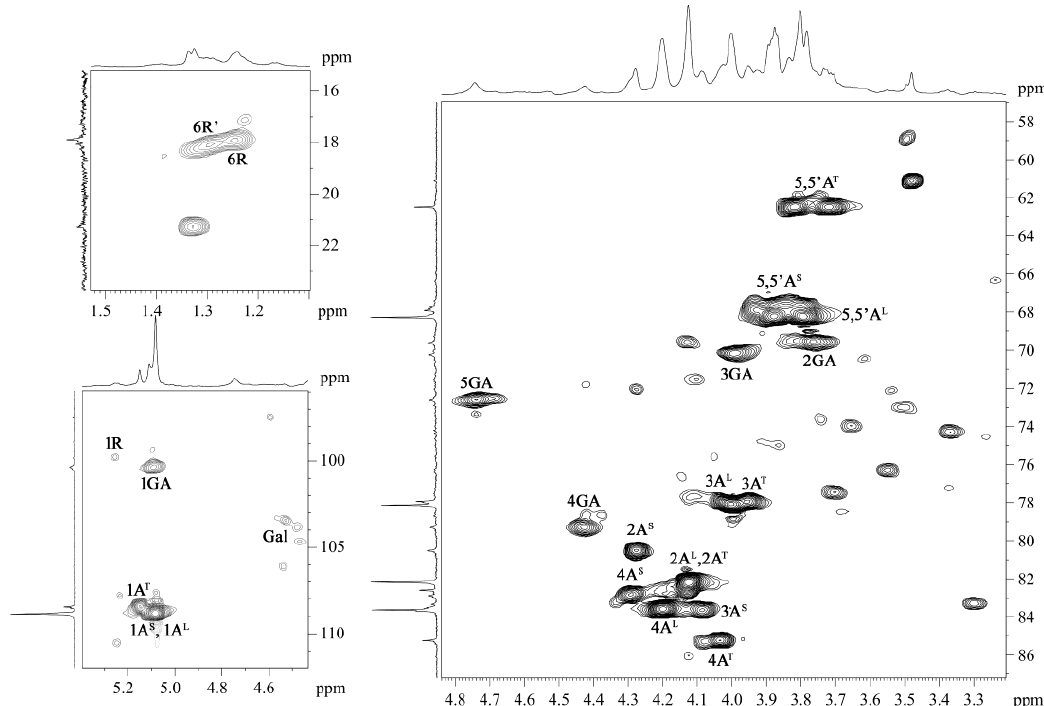
Figure 4. Parts of 1 H, 13 C HSQC spectrum of the SO1-2 . The corresponding parts of the 1 H and 13 C NMR spectra are shown along the X and Y axes, respectively. Arabic numerals refer to the carbon atoms in the residues, as designated in Table 2.